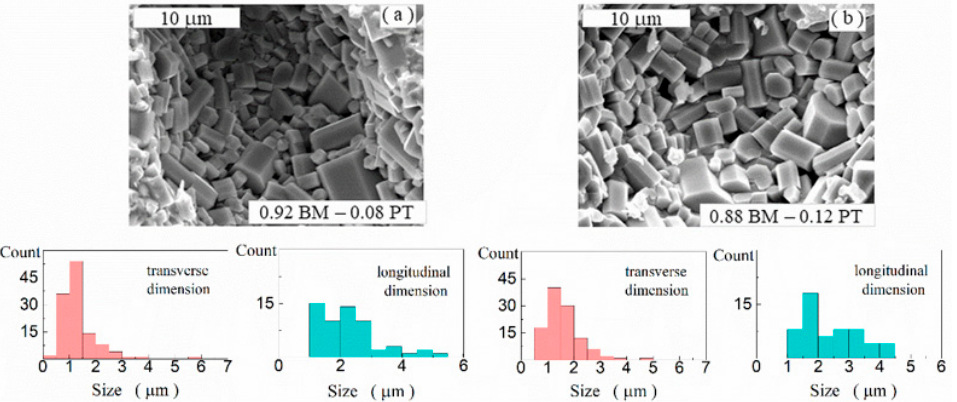
Figure 3. Secondary electron images obtained for 0.92 BM–0.08 PT ceramics ( a ) and 0.88 BM–0.12 PT ceramics ( b ). Histograms show grains’ transverse and longitudinal size distribution.